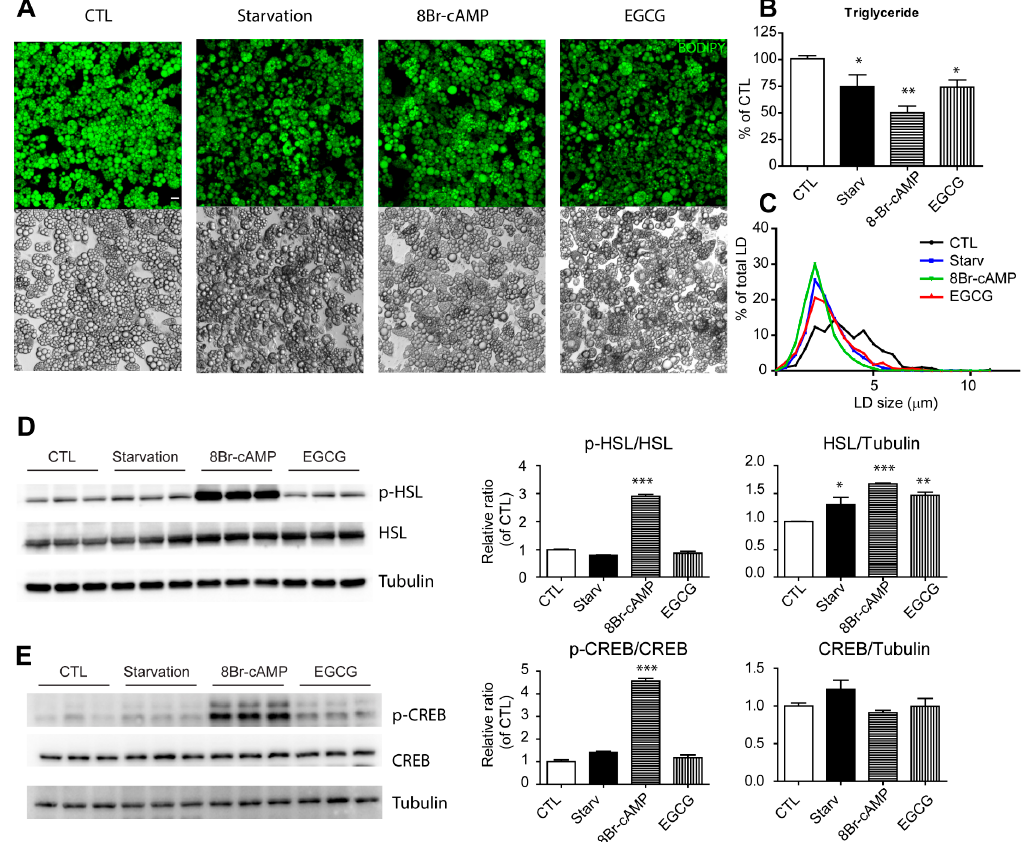
Figure 1. Effects of EGCG on lipid content and PKA signaling in adipocytes ( A – C ) BODIPY staining ( A ), intracellular triglyceride levels ( B ), dimeters of lipid droplets ( C ) in adipocyte differentiated from C 3 H 10 T1/2 cells treated with starvation medium, 8Br-cAMP (1 mM) and EGCG (10 µ M) for 24 h ( D , E ) Immunoblot analysis of p-HSL, HSL, p-CREB, and CREB in adipocyte differentiated from C 3 H 10 T1/2 cells treated with starvation medium, 8Br-cAMP (1 mM) and EGCG (10 µ M) for 24 h. p values were calculated using the two-tailed unpaired t -test ( n = 3, means ± SE; * p < 0.05, ** p < 0.01, *** p <